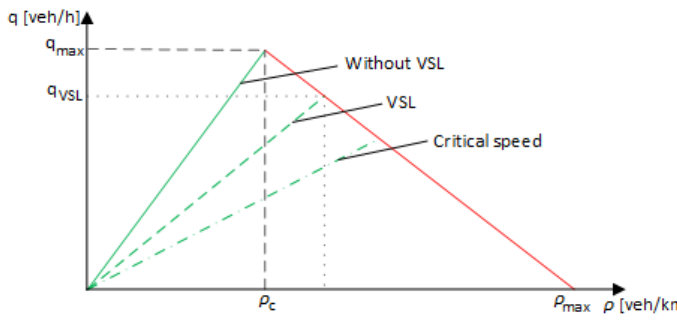
Figure 1. Speed limit effect on the fundamental diagram